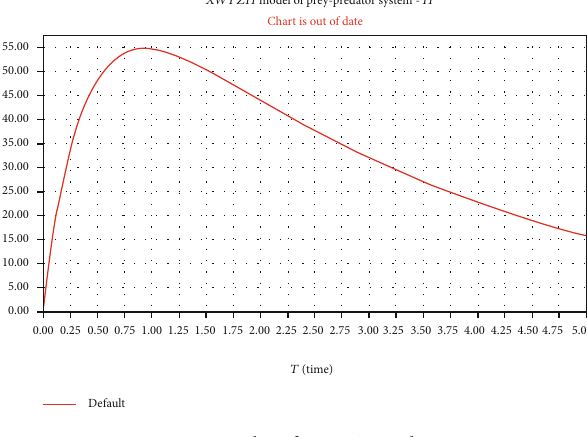
Figure 3: Plots for W , Z , and H